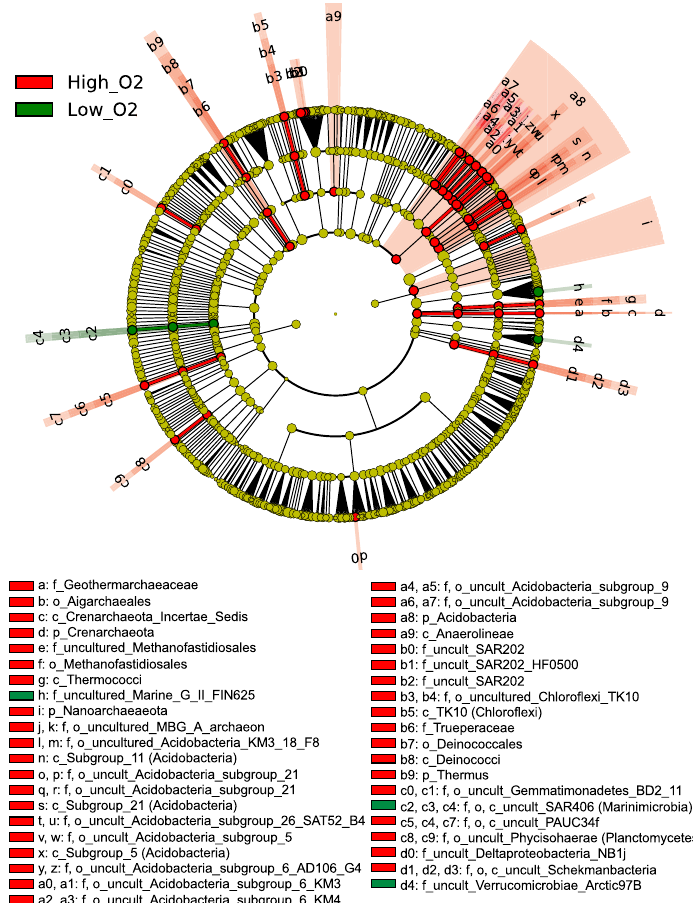
Figure 6. Differential prokaryotic taxa associated to changes in water mass properties. Cladogram showing the phylogenetic distribution of prokaryotic taxa with significantly differential abundance at low or high oxygen concentration computed for the different taxonomic levels. Rings indicate taxonomic levels from domain (inner circle) to family (outer circle). Circle and shaded area colours indicate taxa associated to low (green) or high (red) oxygen concentration for a linear discriminant analysis (LDA) score > 2. Taxa with no significant differences between different oxygen categories are represented by yellow circles. Legend shows the taxonomic level of taxa (p: phylum, c: class, o: order, f: